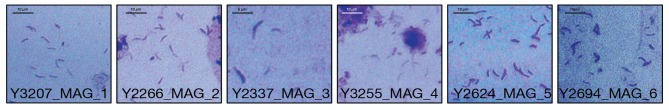
Gram stains of LSVF samples containing >70% “Ca. Lachnocurva vaginae” and used in this study. Morphologically “Ca. Lachnocurva vaginae” is a curved rod. Images are labeled with the sample ID.